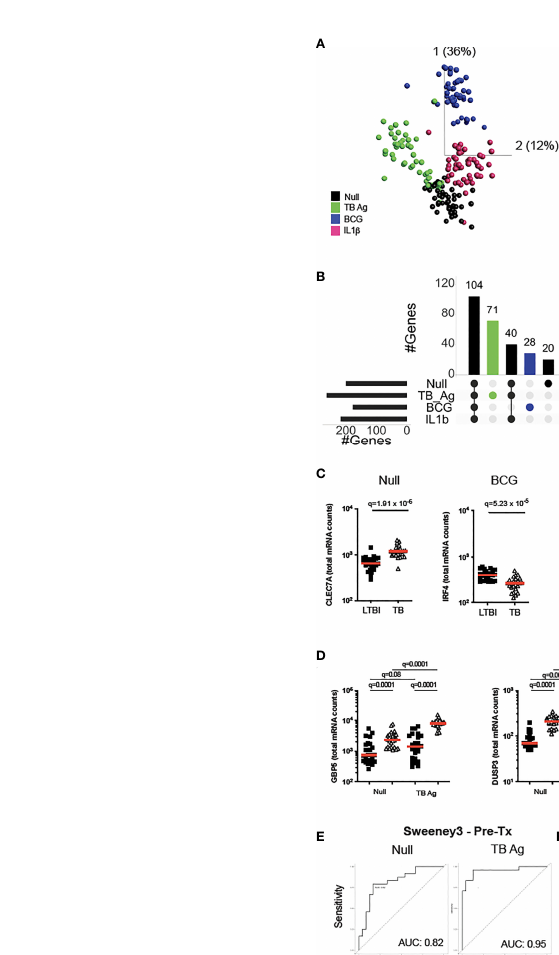
(Supplementary Figure S1E). These differences were not present after successful antibiotic treatment of the TB patients in the Sweeney3 signature (Figure 1F; Null AUC = 0.63 [95% CI (0.45- 0.82)] and TB Ag AUC = 0.51 [95% CI (0.32-0.71)], (p=0.4) or the RISK11 signature (Supplementary Figure S1F; Null AUC = 0.57